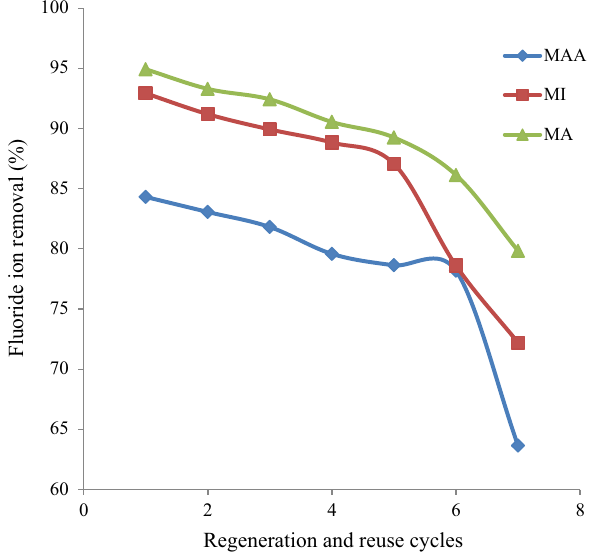
Fig. 6 Performance of the adsorbent for the removal of fluoride after regeneration and